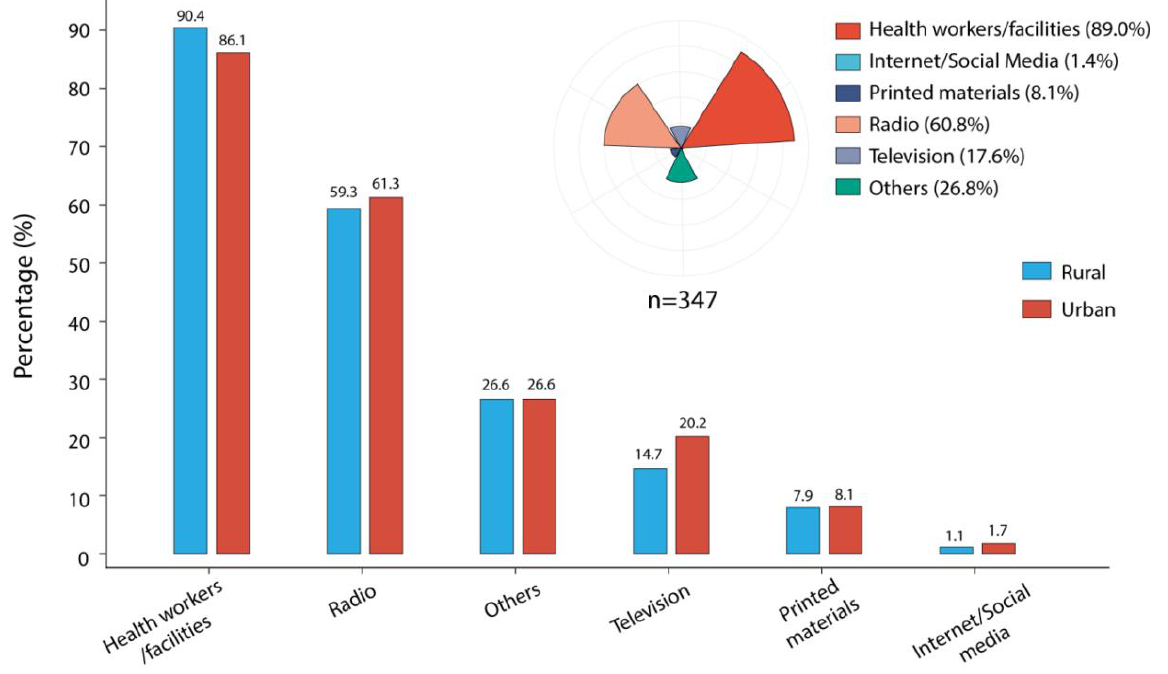
Figure 2. Sources of malaria related information mentioned by caregivers of children under-5. The upper right diagram shows the proportion of each source of malaria related information selected by the caregivers in this study, the different colors represent different sources. The bar plot shows the popularizing rate of the specific source across rural and urban districts, blue and red represent the rural and urban, respectively.